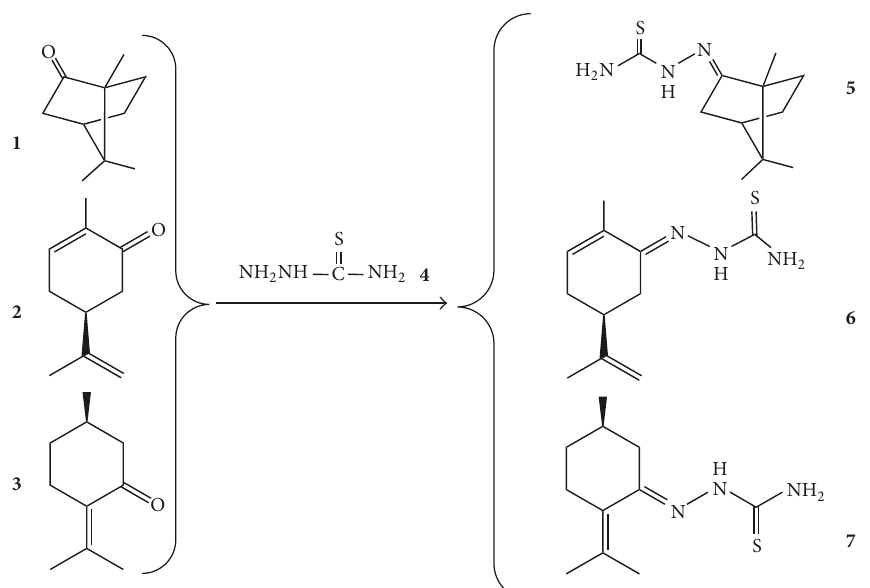
Figure 1: Chemical structure of the Monoterpenic Thiosemicarbazones (5 – 7) and their synthesis from the corresponding naturally occurring monoterpenes (1 – 3)